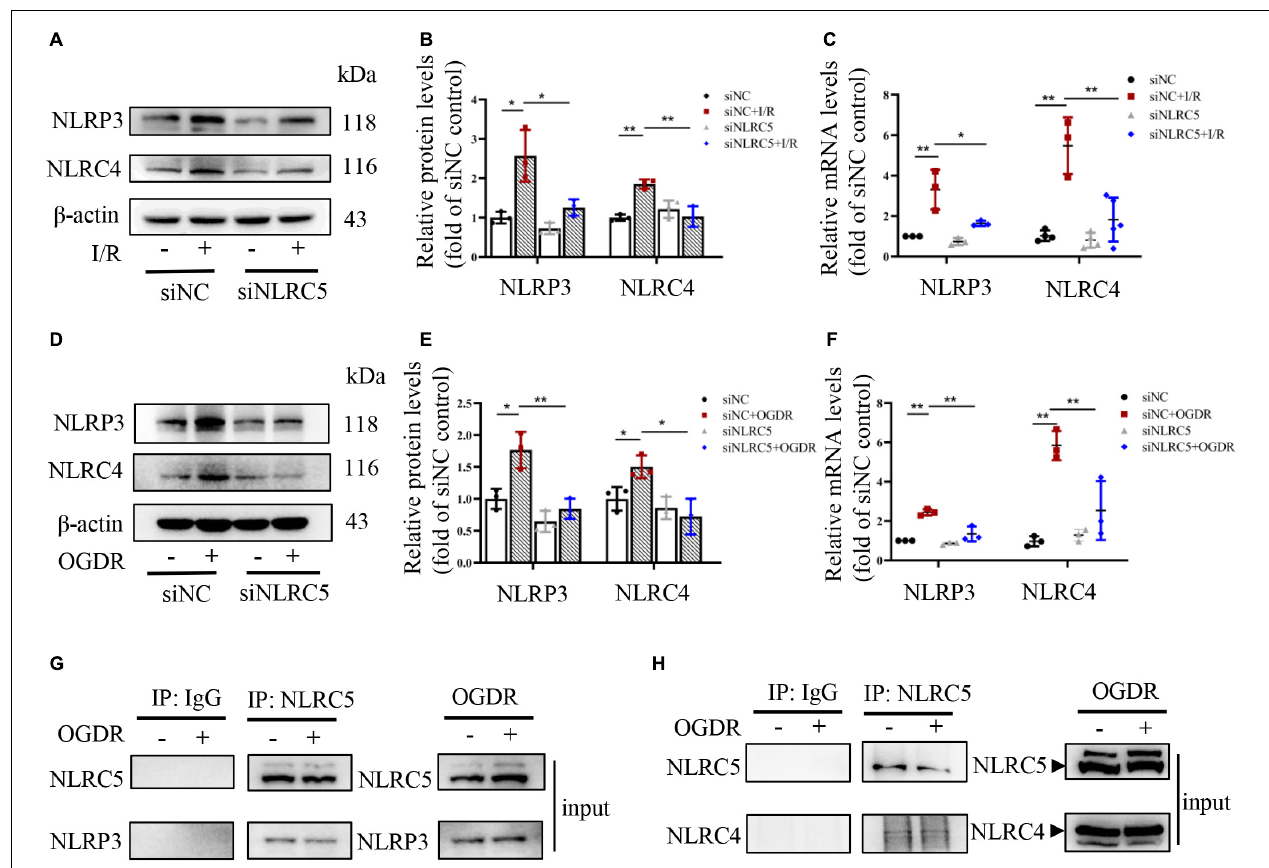
FIGURE 5 | NLRC5 binds to and activates NLRP3/NLRC4 inflammasomes during RIR or OGDR. (A–F) Western blot and RT-qPCR analysis of NLRP3 and NLRC4 expression in BV2 microglial cultures and mouse retina following OGDR and RIR, respectively. Expression levels of both proteins and mRNAs were elevated in vivo and in vitro by RIR or OGDR. Elevated expression levels following OGDR were markedly suppressed by NLRC5 knockdown. (G,H) Co-immunoprecipitation assay showing that NLRC5 interacts with NLRP3/NLRC4 in BV2 cells subjected to OGDR. All data shown are representative of at least three independent experiments and presented as mean ± SD. * P < 0.05, ** P < 0.01. Two-way ANOVA with post hoc Bonferroni tests was applied. I/R, retinal ischemia–reperfusion; OGDR, oxygen-glucose deprivation and